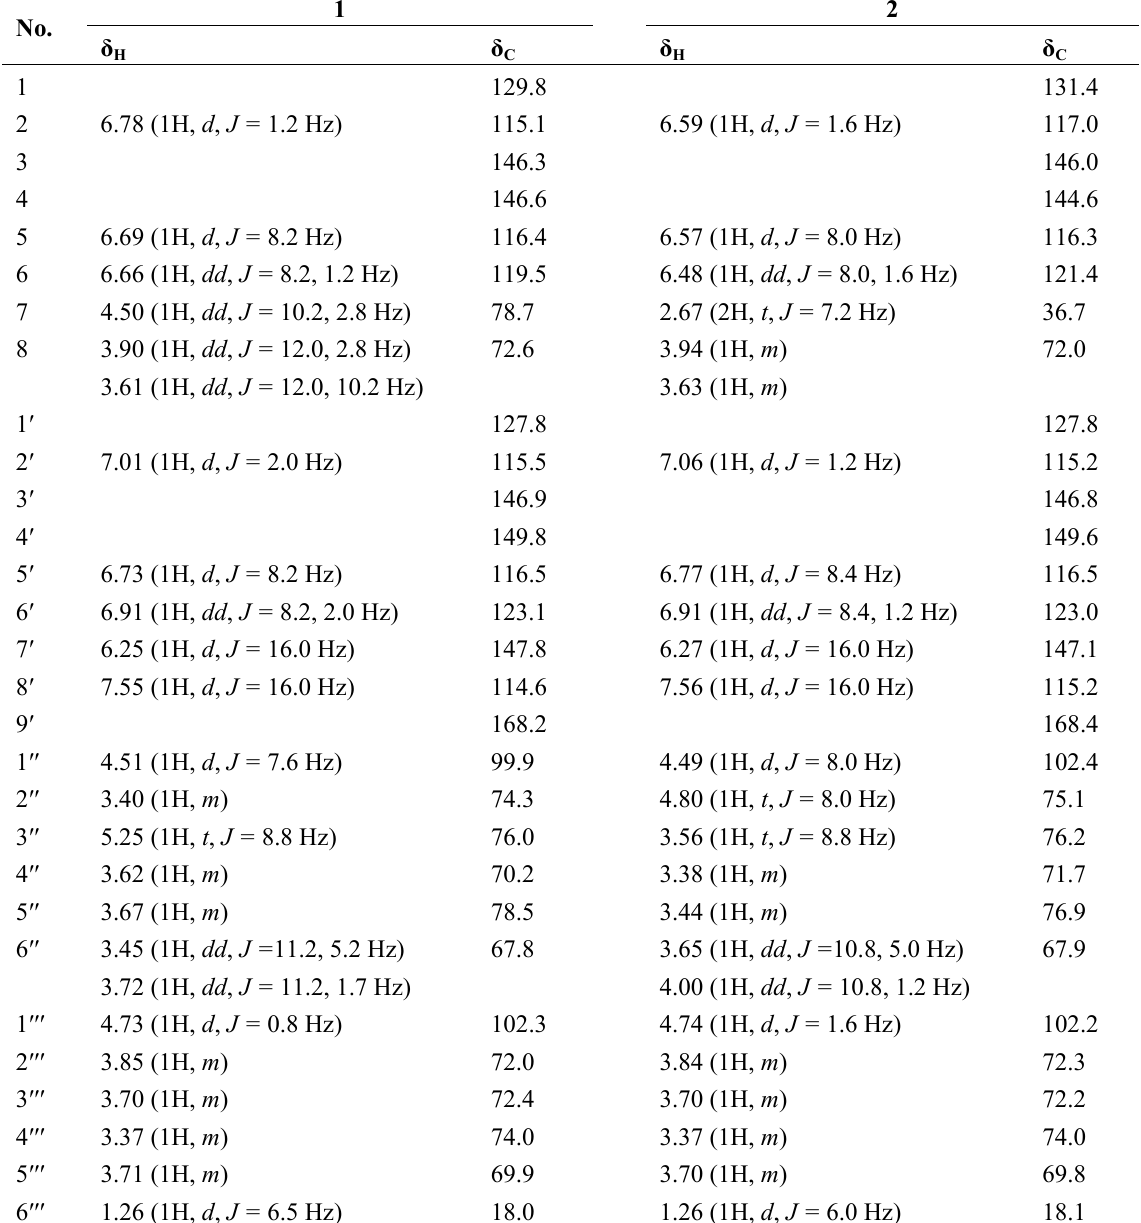
OD at 400 MHz and 100 MHz, J in 3